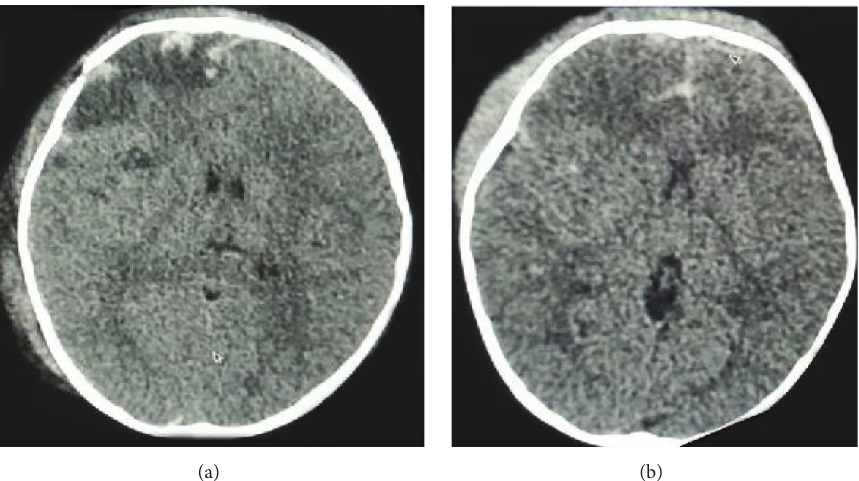
Figure 1: Computed tomography of head showing fracture of right frontal bone and subdural hematoma and extradural hematoma with contusion and subarachnoid hemorrhage.